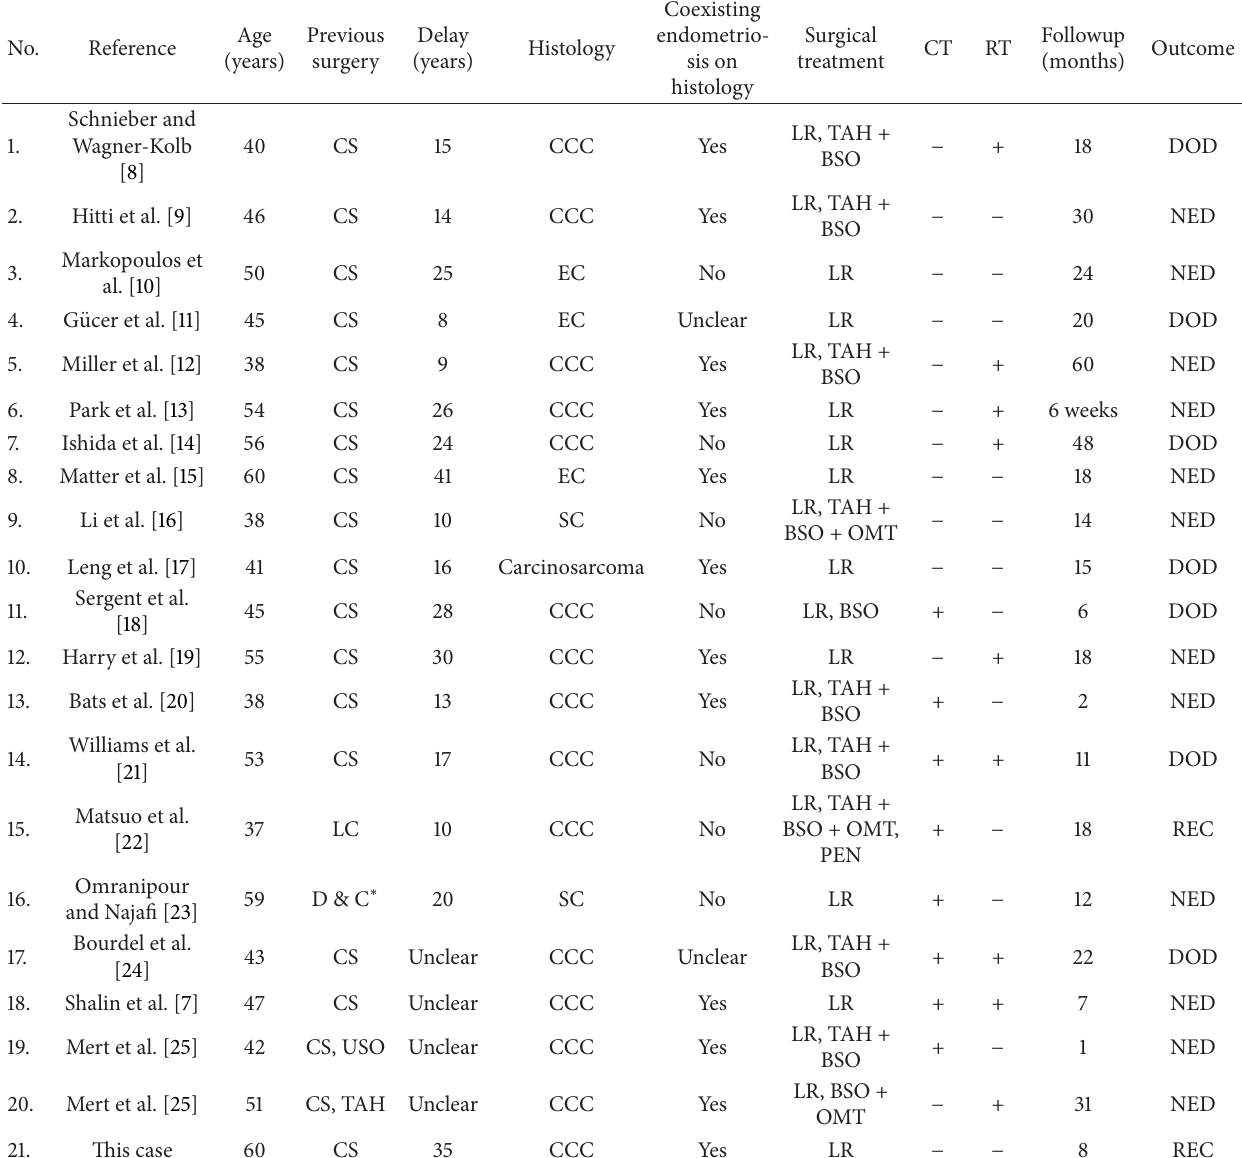
Table 1: Twenty-one cases of malignant transformation from abdominal wall